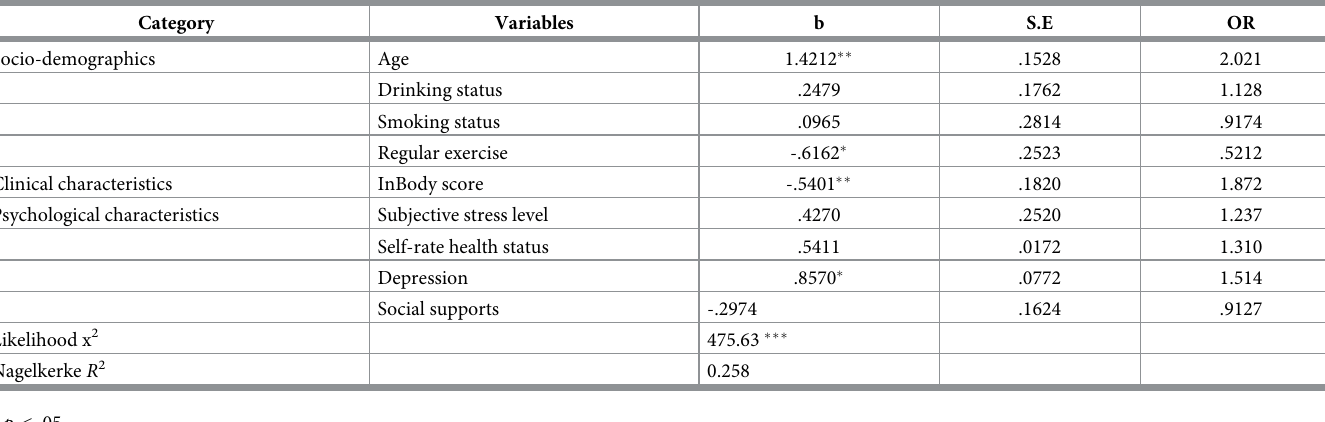
Table 3. Odds ratios of ordinal logistic regression model of metabolic syndrome risk score ( N =